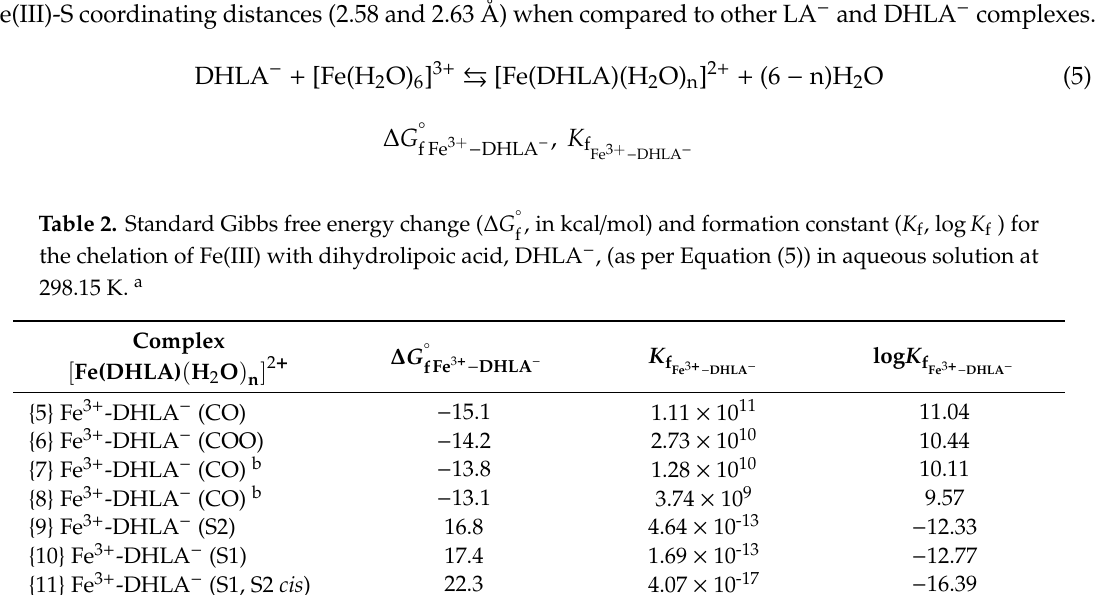
Table 2. Standard Gibbs free energy change (∆𝐺 (cid:3033)° , in kcal/mol ) and formation constant (𝐾 (cid:2916) , log𝐾 (cid:2916) ) for the chelation of Fe(III) with dihydrolipoic acid, DHLA − , (as per Equation (5)) in aqueous solution at 298.15 K.